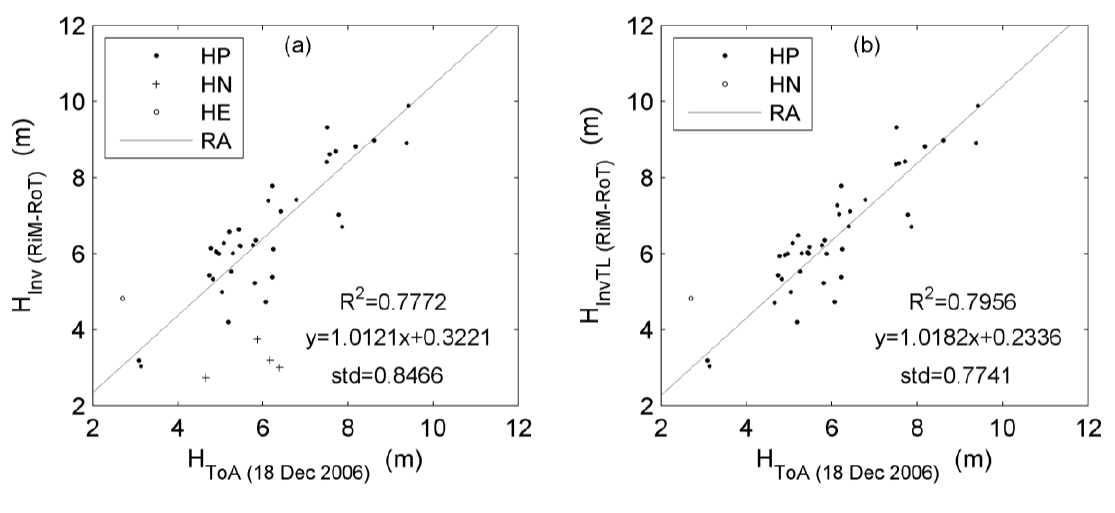
Figure 8. Scatterplots of the tree heights derived from the ToA data and the tree heights inversely derived by combining the RoT and RiM data before relative revision ( a ) and after relative revision ( b ). See text for the definition of